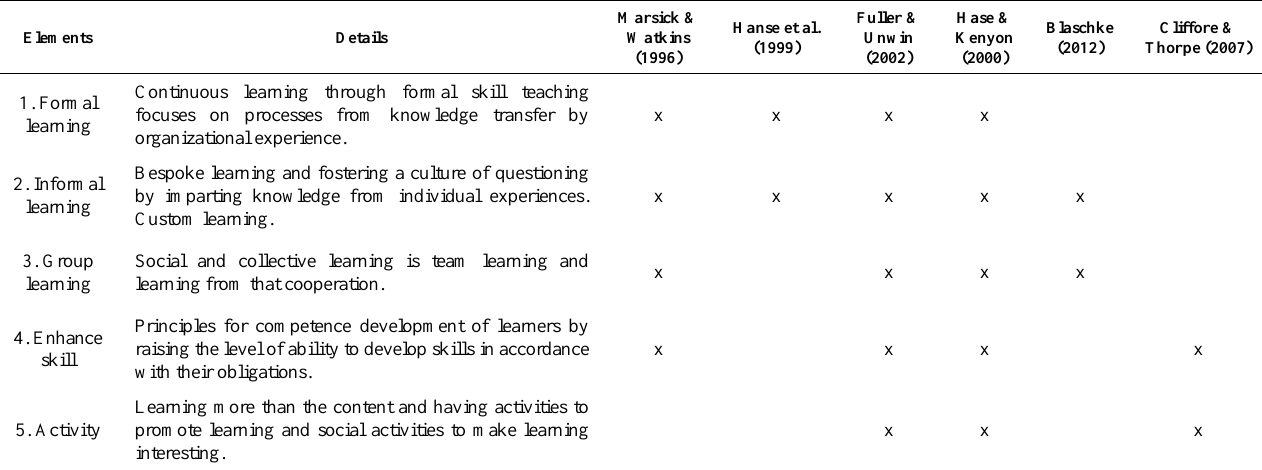
Table 2. The synthesis of the elements of workplace